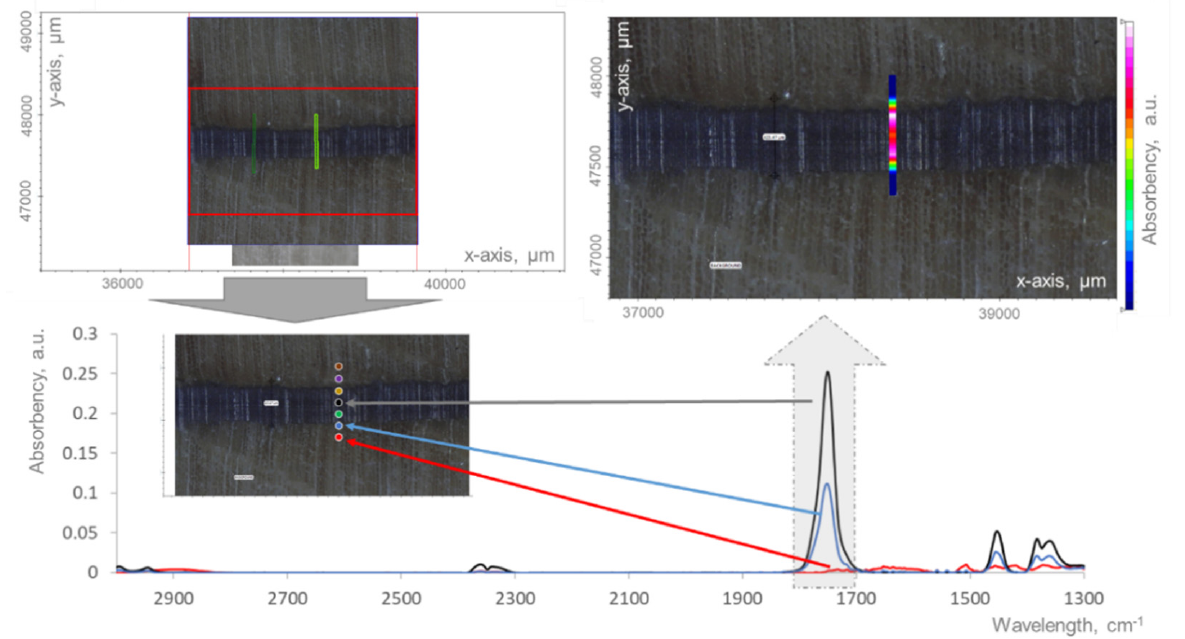
Figure 2. Chemical spatial imaging of the PLA carbonyl peak profile of the 5-ply panel outer bondline of the 160 °C, 600 s semi-crystalline sample.